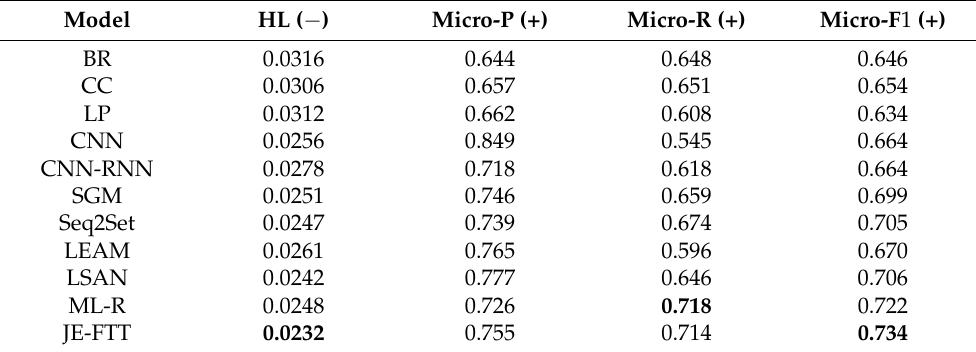
Table 3. Comparative experiments on the AAPD